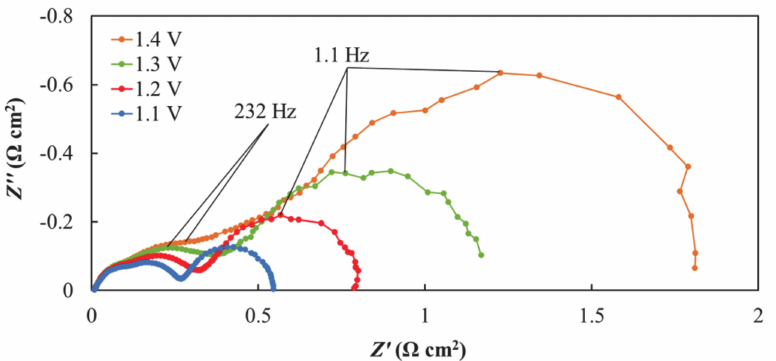
Figure 7. Effect of voltage (noted in figure) on impedance of the electrolysis cell. Nyquist plots was measured 174 h from the start of electrolysis test. T = 800 ◦